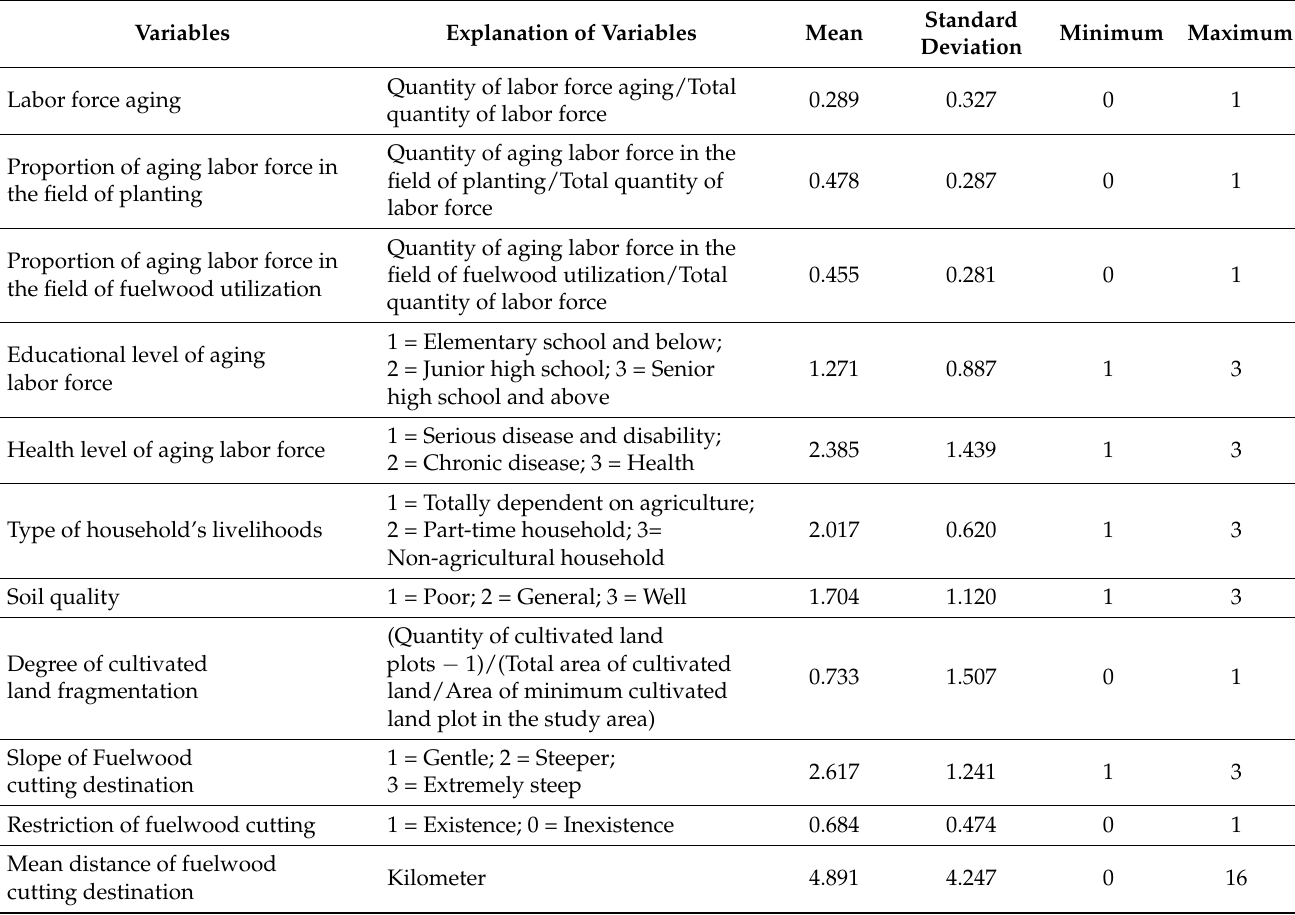
Table 2. Characteristic of study